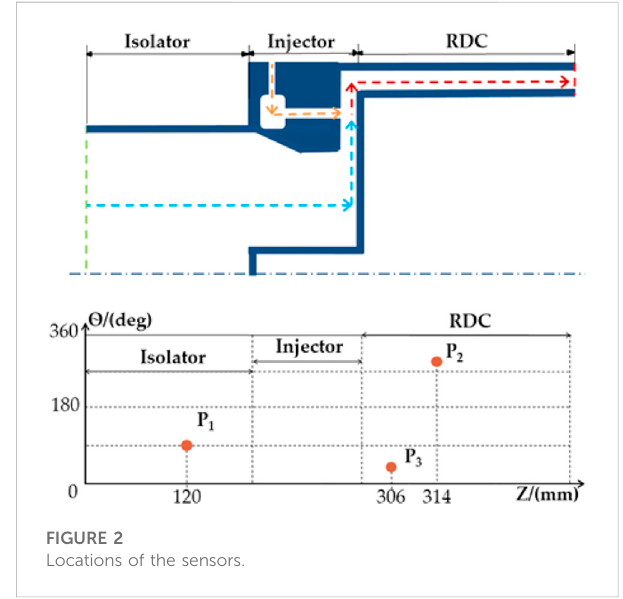
FIGURE 2 Locations of the sensors.